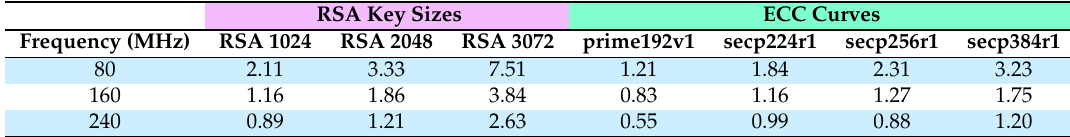
Table 3. Average time per request (seconds) for the tested RSA key sizes, ECC curves and SoC frequency